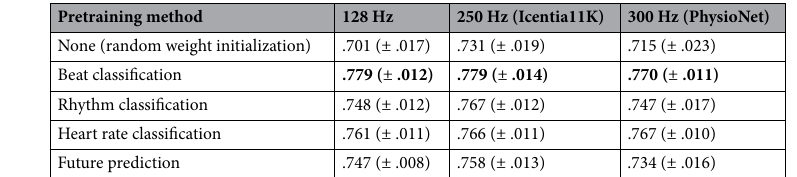
Table 3. Comparison of the pretraining methods depending on the sampling frequency (Hz) of the downstream data set. For each method, we report the average macro F 1 score (and the standard deviation) on our test set for the PhysioNet/CinC Challenge 2017 7,8 . Note that all networks are pretrained on ECG data sampled at 250 Hz, regardless of the sampling frequency during finetuning. Pretraining is beneficial even if networks are not specifically trained to deal with ECG data sampled at different